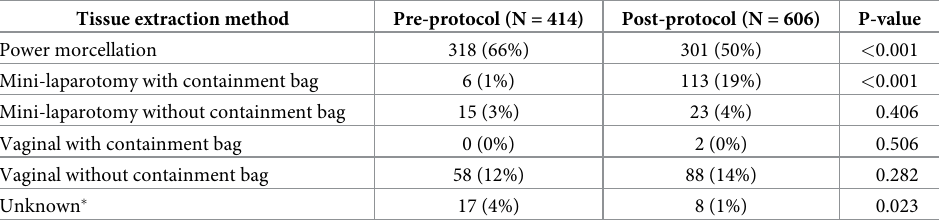
Table 4. Rates of tissue extraction methods in patients who had MIS surgery in pre-and post-protocol